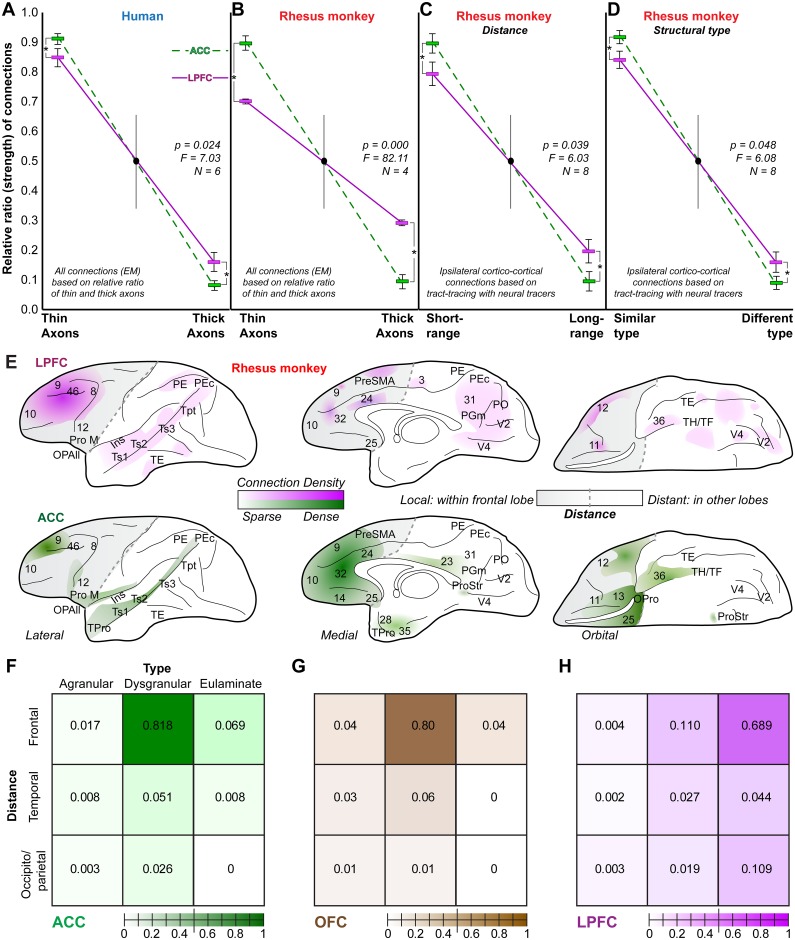
Density of thin and thick axons in the prefrontal cortex (PFC) white matter reflects short-range and long-range connectivity between areas of similar or different structure.(A) Relative ratio of thin to thick axons in human anterior cingulate cortex (ACC) and lateral prefrontal cortex (LPFC) based on the study of axons in the white matter at the electron microscope (EM) (thin/thick axons ± SE in ACC, 92/8 ± 1%; in orbitofrontal cortex [OFC], 86/14 ± 2%, not shown; and in LPFC: 85/15 ± 3%). (B) Relative ratio of thin to thick axons in rhesus macaque ACC and LPFC based on the study of axons in the white matter at the EM (thin/thick axons ± SE in ACC, 89/11 ± 2%; in OFC, 86/14 ± 2%, not shown; and in LPFC: 71/29 ± 0.4%). (C) Relative ratio of short-range to long-range connections in rhesus macaque ACC and LPFC, based on tract-tracing studies of ipsilateral corticocortical connections labeled with neural tracers (short-range/long-range connections ± SE in ACC: 90/10 ± 3%; in OFC, 87/13 ± 4%, not shown; and in LPFC: 80/20 ± 4%). (D) Relative ratio of connections with similar or different types of cortices in rhesus macaque ACC and LPFC, based on tract-tracing studies of ipsilateral corticocortical connections labeled with neural tracers (similar/different cortical type connections ± SE in ACC, 92/8 ± 2.4%; in OFC, 87/13 ± 1.6%, not shown; and in LPFC: 84/16 ± 3%). (E) Lateral (left), medial (center), and orbital (right) surface heat maps of the rhesus macaque brain show the relative strength of connections of LPFC (top) and ACC (bottom) with other nearby (frontal) or distant (temporal, parietal, and occipital) cortices. The maps are based on extensive quantitative data from tract-tracing studies with neural tracers. The frontal lobe that includes short/medium-range pathways is shaded in light gray and is separated from other lobes with a dotted line. (F–H) Matrices of the relative strength of the connections of ACC (F), OFC (G), and LPFC (H) with nearby or distant cortical areas of similar or different type. Frontal areas are grouped as nearby, and temporal and occipito/parietal areas are grouped as distant. We used 3 structural types for this analysis: agranular (no layer 4), dysgranular (thin layer 4), and eulaminate (6 well-delineated layers, thick layer 4). Analyses showed that all PFC cortices are primarily connected with nearby cortices of similar structural type. LPFC had relatively more connections with distant cortices of similar type compared to ACC. The tract-tracing connectional data paralleled the EM data from the study of the thickness and density of white matter axons below the areas studied and suggested that in monkeys and humans thin axons primarily link nearby areas of similar structural type through robust connections, while thick axons participate in long-distance connections. ACC, shades of green and dotted lines; OFC, shades of brown; and LPFC, shades of purple and purple solid lines. Asterisks indicate significant differences (1-way ANOVA). Abbreviations: Ins, Insula; OPAll, orbital periallocortex; OPro, orbital proisocortex; Pro M, motor proisocortex; PE, posterior parietal area PE; PEc, posterior parietal area PEc; PGm, posterior parietal area PGm; PO, parietoccipital area; PreSMA, pre supplementary motor area; ProStr, area prostriata; TE, inferior temporal area; TH/TF, parahippocampal areas; TPro, temporal proisocortex; Tpt, temporoparietal area; Ts1, superior temporal area 1; Ts2, superior temporal area 2; Ts3, superior temporal area 3; V2, visual area 2; V4, visual area 4. The numerical data underlying this figure can be found in S1 Data.